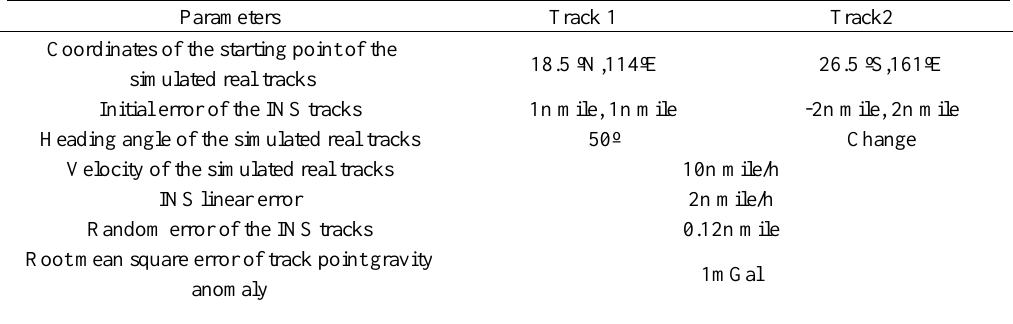
Table 1 . Simulated tracks and